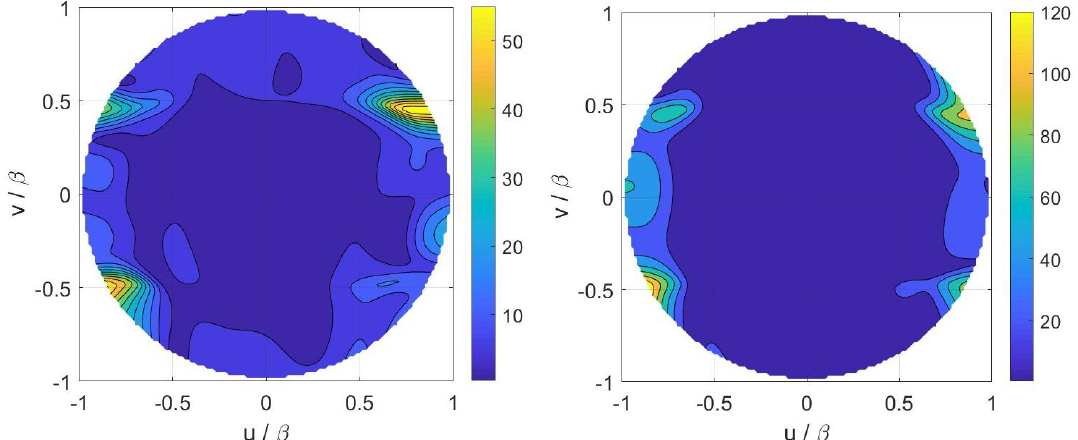
Figure 6. Case A—( Left ) percentage error of the FFP (Far Field Pattern) retrieved in the mutual information case. ( Right ) percentage error of the FFP retrieved in the Fisher information